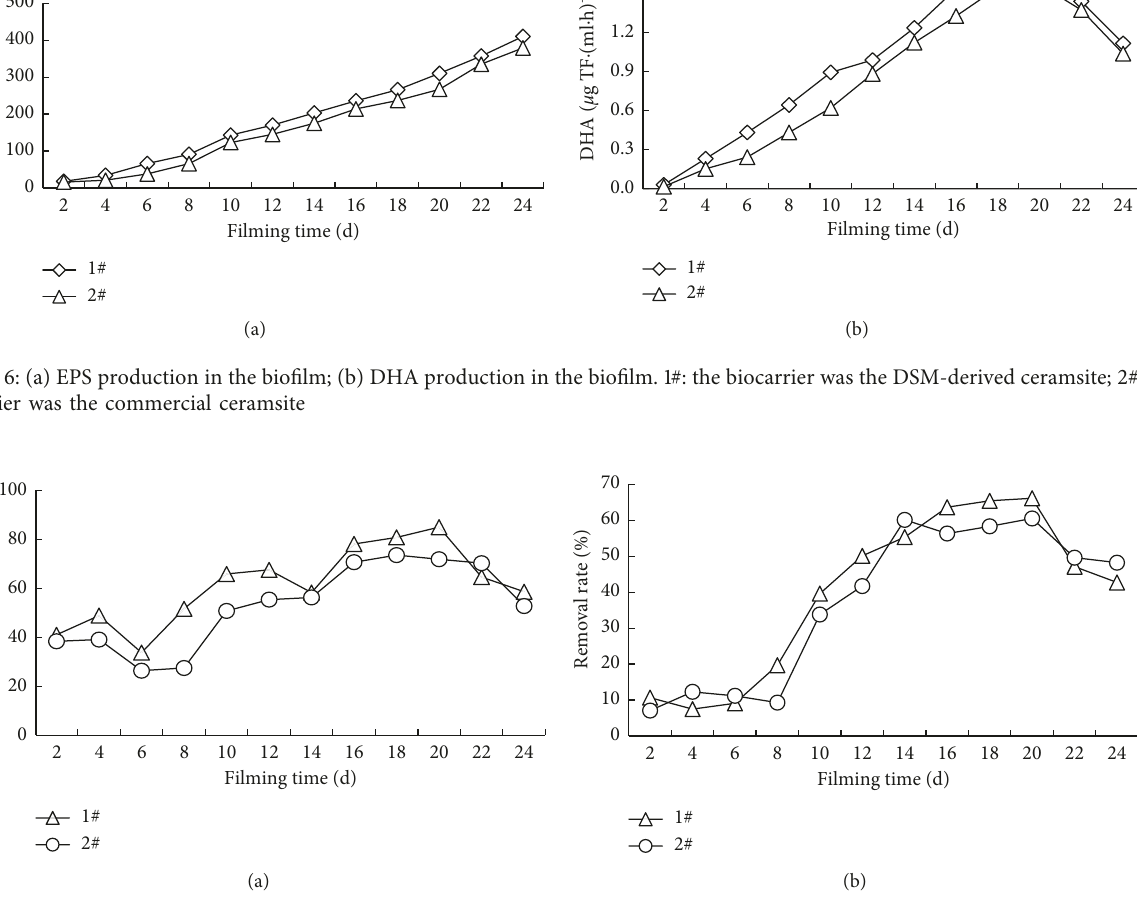
Figure 7: (a) Change of COD 4+ -N removal rate during film hanging.1#: the DSM-derived Mn removal rate during filming. (b) Change of NH ceramsite condition; 2#: the commercial ceramsite condition.